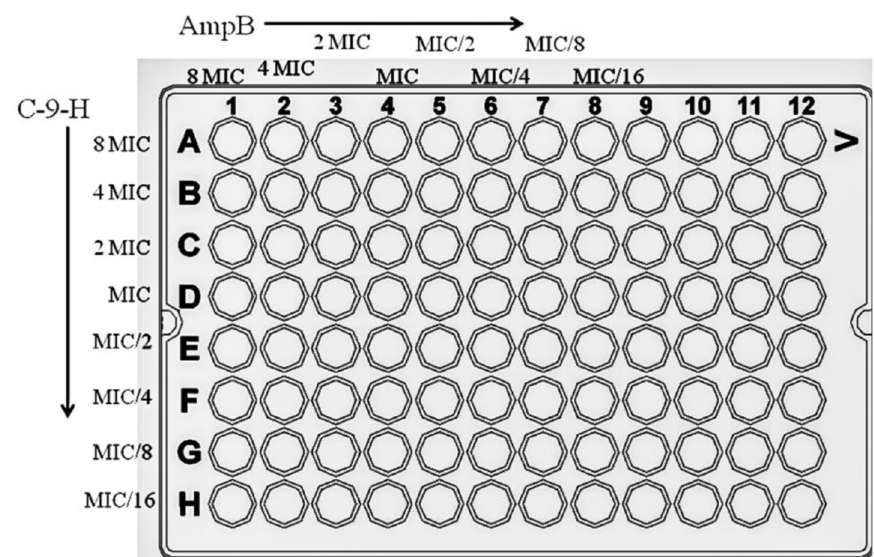
Fig. 1. Microdilution checkerboard method for FIC determination. Dilution of the drug amphotericin B was made horizontally whereas; cis-9-hexadecenal was diluted vertically. In both cases, the range of test sample was from 8 MIC to